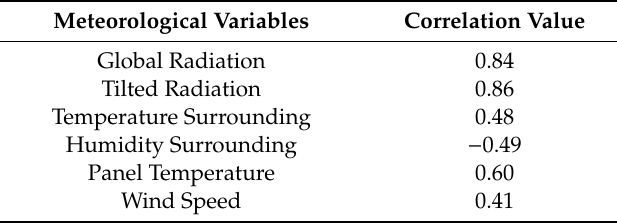
Table 2. Correlation value between solar power and meteorological